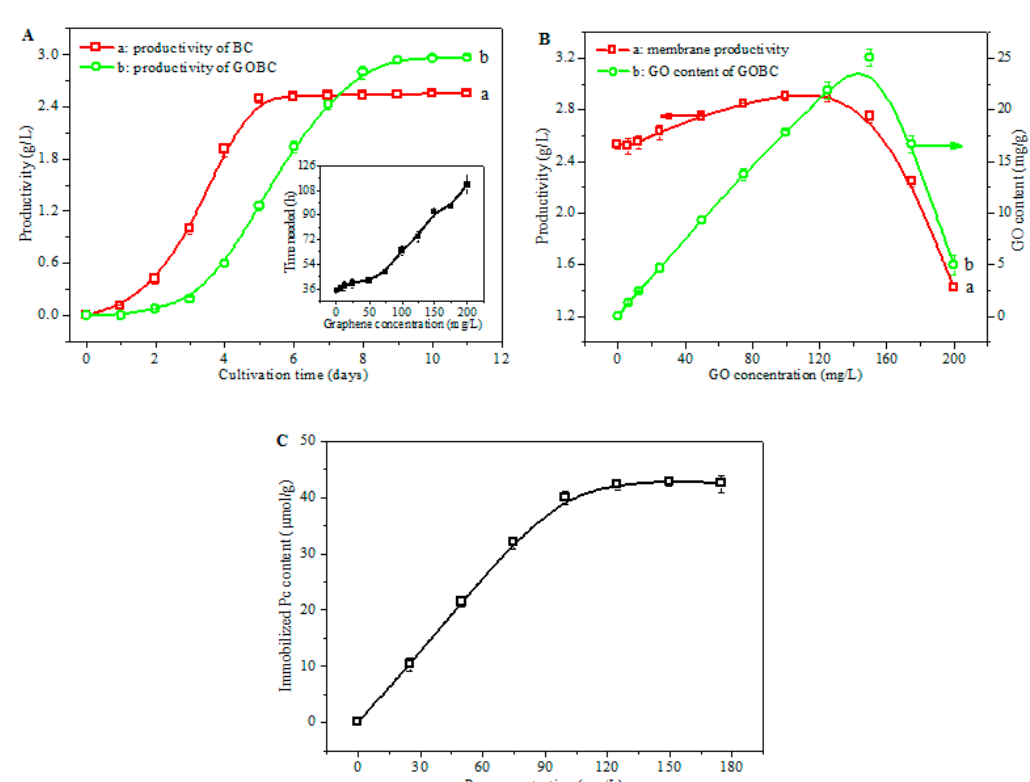
Figure 3. ( A ): Influence of cultivation time on the productivity of (a): BC; (b): GOBC membrane; the inset showed the influence of intial GO concentration on the time needed to produce 0.3 g/L of membrane. ( B ): Influence of initial GO concentration on (a): the productivity of the membrane; (b): the GO content of the membrane (cultivation time was set as 10 d). ( C ): Influence of Pc concentration on the immobilized Pc content of Pc-rGBC nanocomposite (the GO content of the GOBC membrane was set as 2.92 g/L).